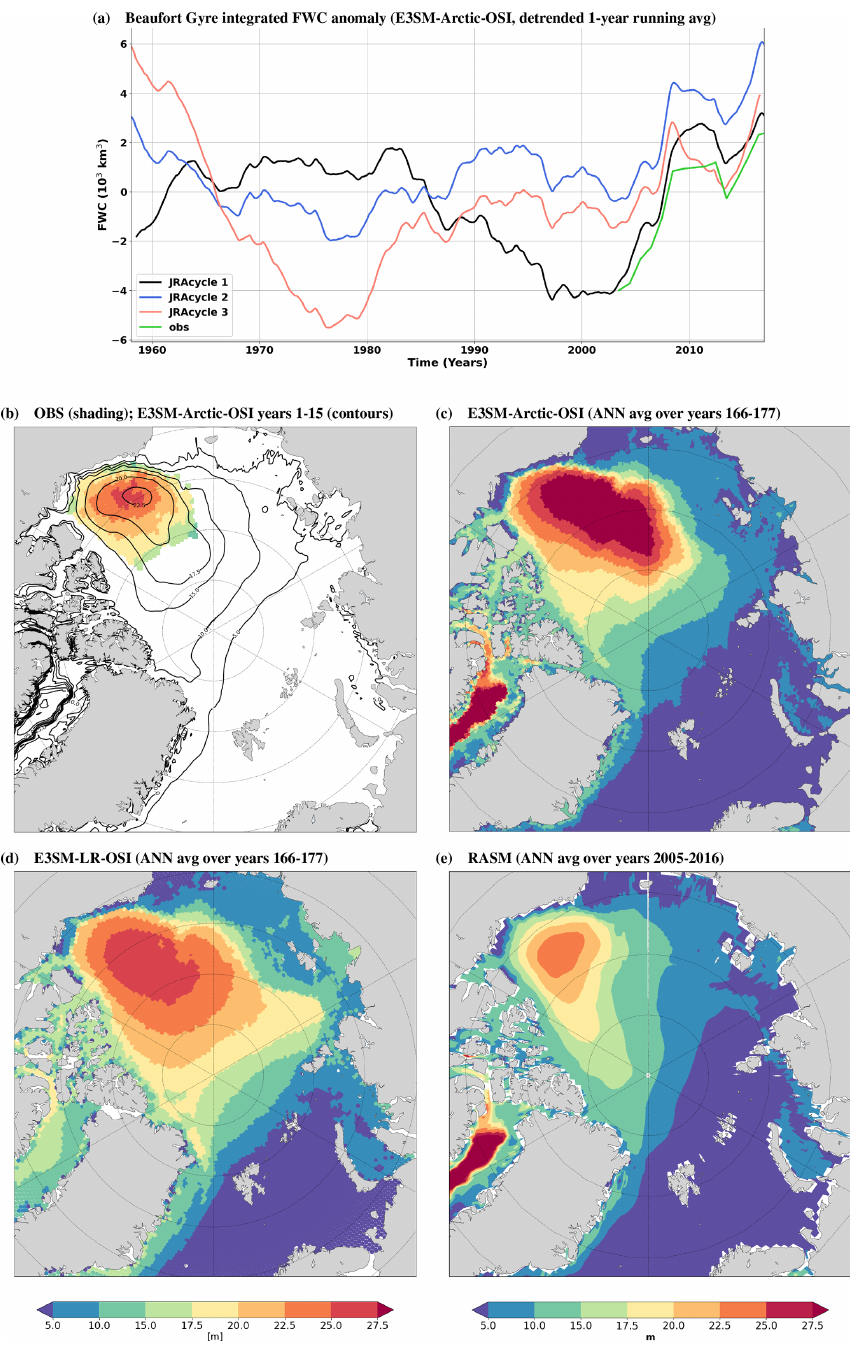
Figure 16. (a) Time series of Beaufort Gyre integrated freshwater content (detrended and 1-year running-averaged) from the E3SM-Arctic- OSI simulation (black, blue, and pink lines indicate results from the three JRA cycles). Green line is the WHOI observational counterpart (anomaly computed by removing the 2003–2018 mean). (b–e) Annual climatology of freshwater content with respect to a salinity reference of 34 . 8psu, computed from (b) observations over the years 2003–2018, (c) E3SM-Arctic-OSI over the final 12 years of the third cycle (years 166–177, corresponding to 2005–2016), (d) E3SM-LR-OSI over years 166–177, and (e) RASM over the years 2005–2016. Contour lines in panel (b) show the E3SM-Arctic-OSI annual climatology for the first 15 years of the first JRA cycle.